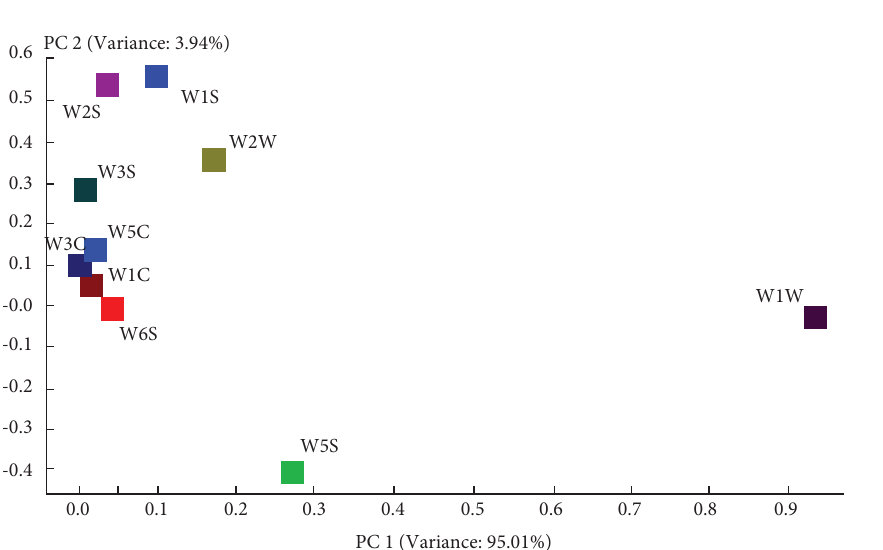
Figure 8: PCA model analysis diagram of “Yali” pear paste prepared under traditional heating and vacuum concentration temperatures. CK: pear paste prepared by traditional heating concentration; Vacuum concentration: pear paste prepared at 65 ° C of vacuum concentration.